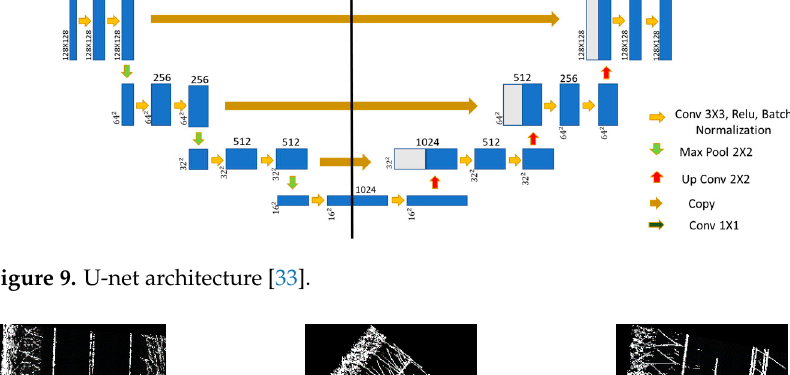
Figure 9. U-net architecture [33].